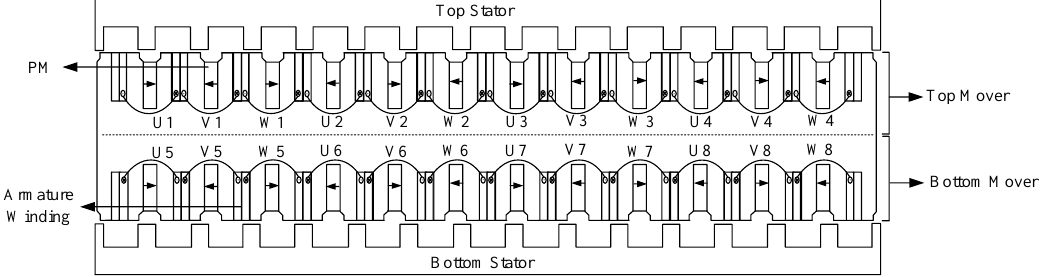
Figure 2. 2D cross-sectional view of DSLFSPMM.